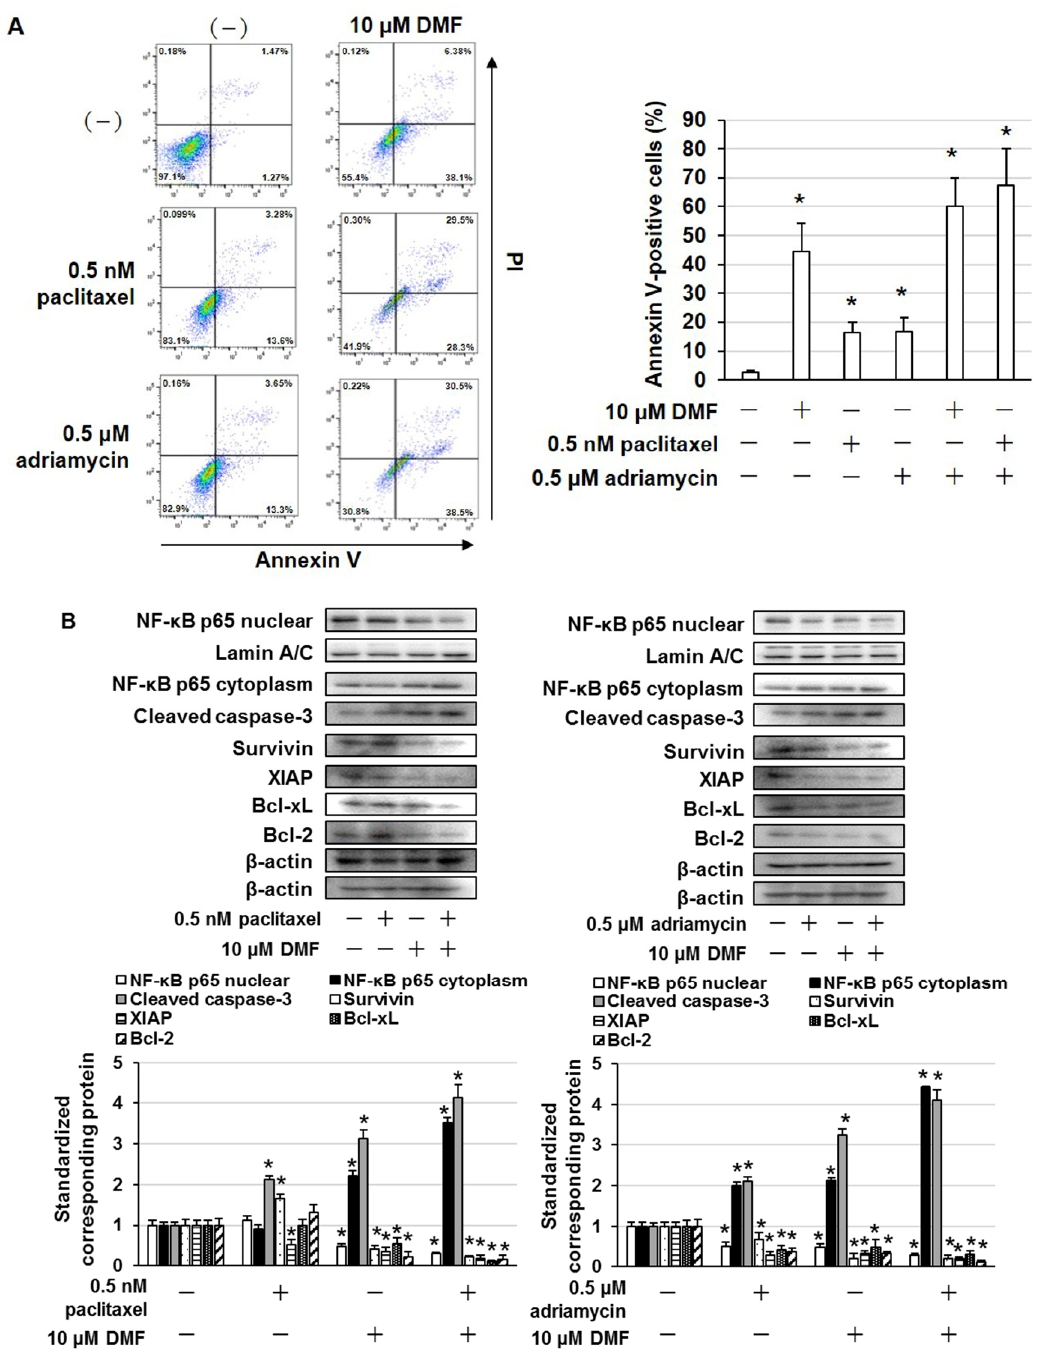
Figure 6. DMF enhanced the apoptosis-inducing effect of paclitaxel and adriamycin in MDA-MB- 231 cells. ( A ) MDA-MB-231 cells were treated with the shown concentrations of DMF, paclitaxel, or adriamycin for 72 h and then stained using an Annexin V apoptosis assay kit. The results are exemplary of four independent experiments. * p < 0.01 vs. untreated cells. ( B ) DMF-, paclitaxel-, or adriamycin-treated cell lysates were evaluated by immunoblotting using the shown antibodies. The contents of nuclear NF- κ B p65, cytoplasmic NF- κ B p65, cleaved caspase-3, Survivin, XIAP, Bcl-xL, and Bcl-2 were quantified and standardized to the contents of Lamin A/C or β -actin. The results are exemplary of three independent experiments. * p < 0.01 vs. untreated